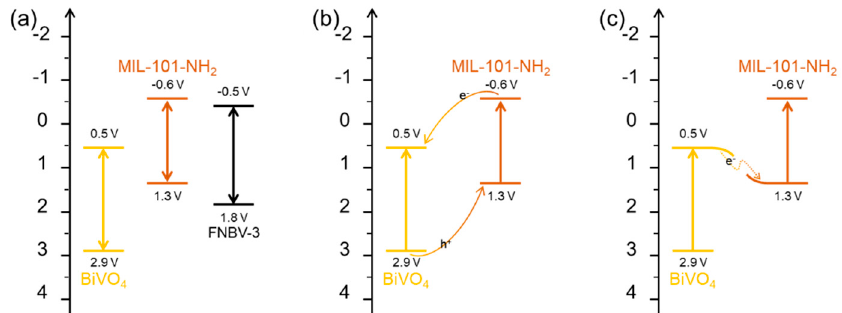
Figure 7. ( a ) Band structures of MIL–101–NH 2 /BiVO 4 ; schematic diagram of ( b ) traditional and ( c ) Z–scheme heterojunction pathway for carrier separation.